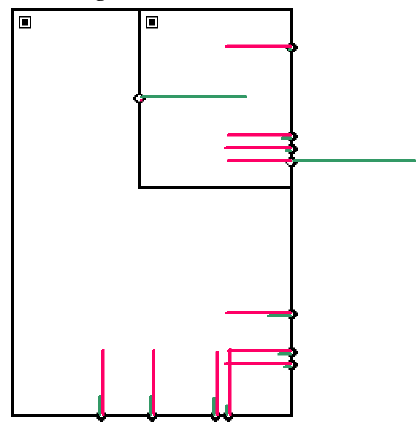
Figure 9. CONTAM simulation results for Scenario 2 assuming an ACH 50 of 3.0 h − 1 : relative quantities of airflow volumes and direction (green bars); relative pressure differentials and pressurization mode (red bars).